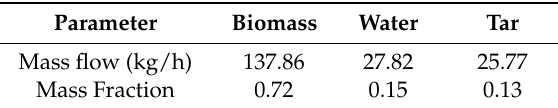
Table 2. Dried biomass entering the gasifier.